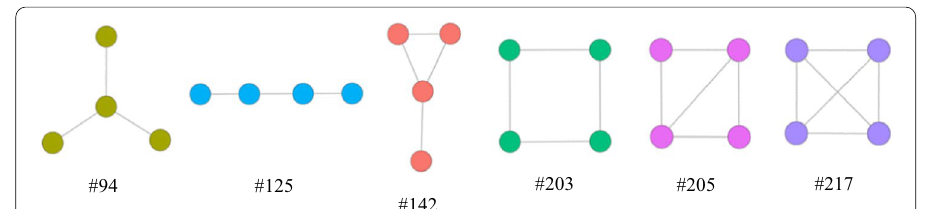
Fig. 5 Six isomorphic tetrads of interest. Tetrads are labeled according to their directed isomorphic